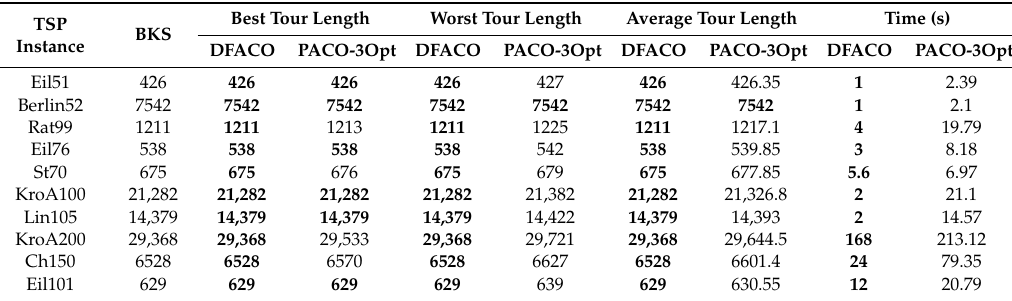
Table 3. DFACO and PACO-3Opt comparison on small-scale datasets.